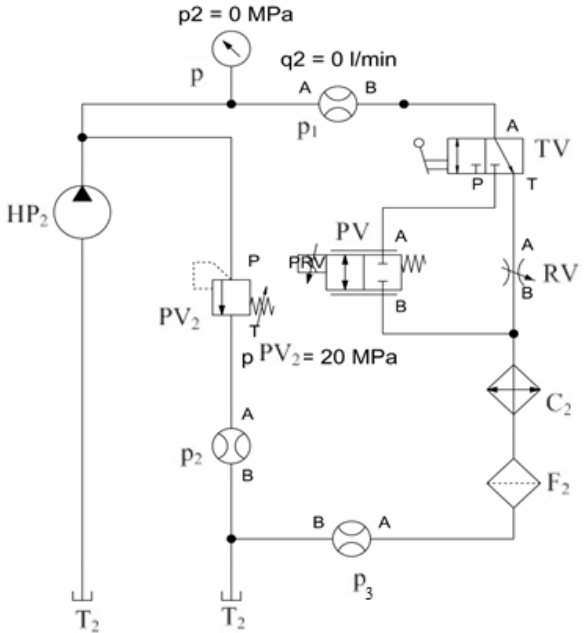
Figure 5. Scheme of the secondary hydraulic circuit of laboratory test equipment. Legend: HP2—